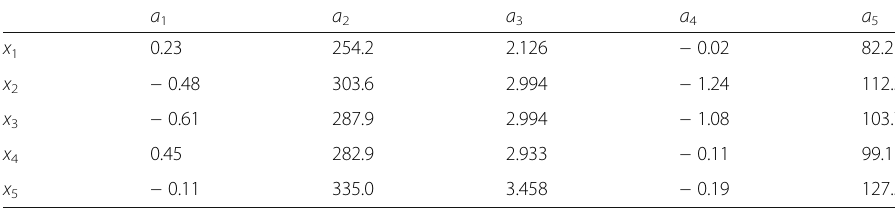
Table 2 Quantitative attributes of five amino